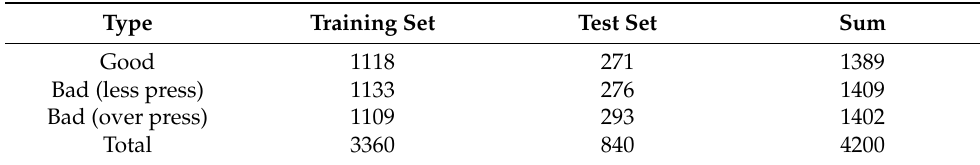
Figure 5. Preparation of input images by cropping an original image. Table 2. The type and number of dataset.